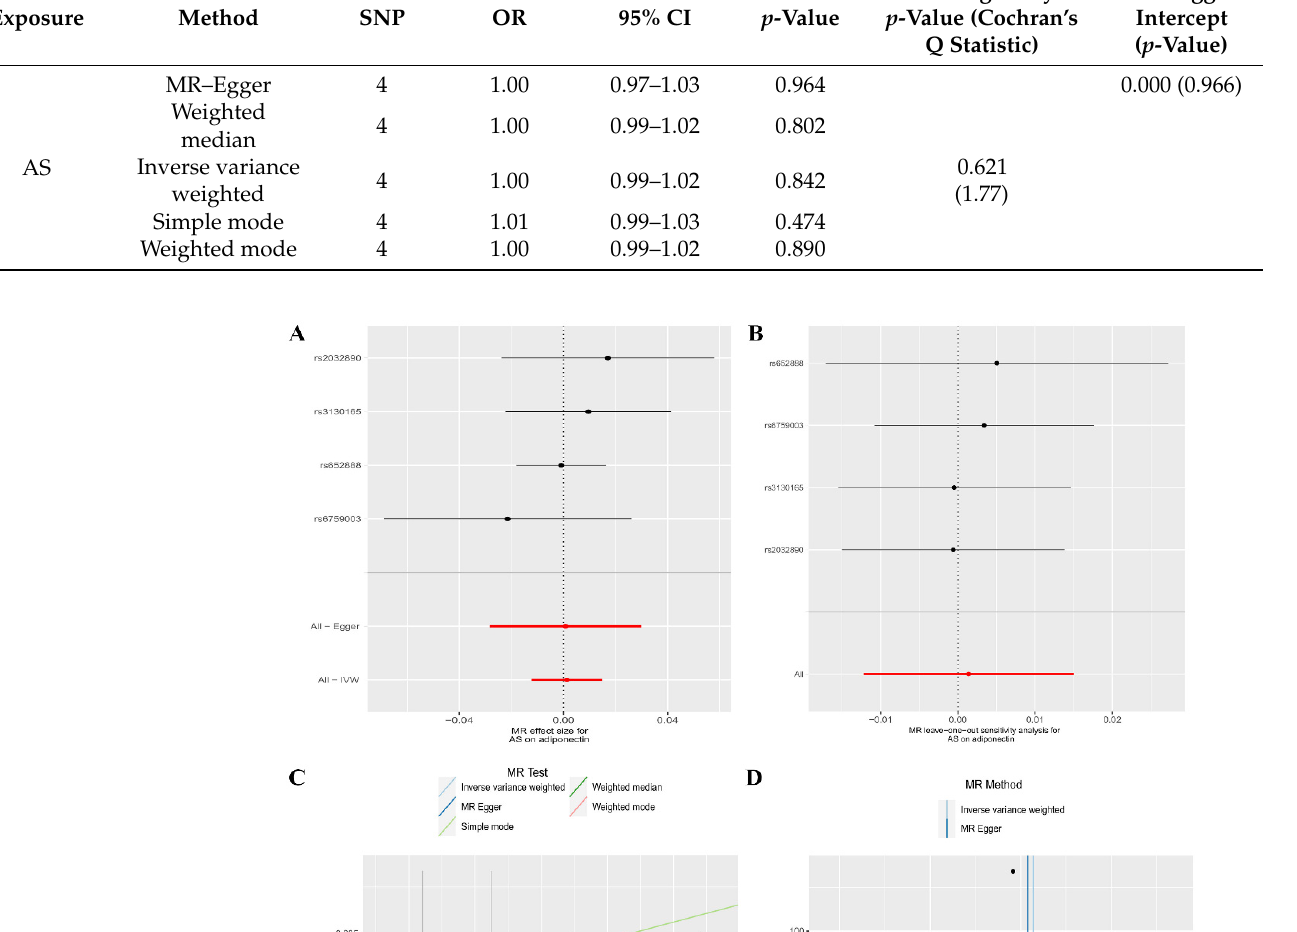
Table 4. The results of a Mendelian randomization analysis of the relationship between the risk of ankylosing spondylitis and circulating adiponectin levels.